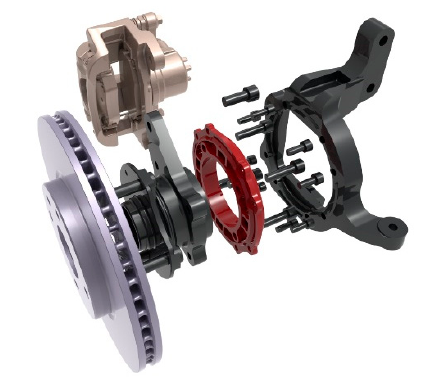
Figure 2. Installation location of the spoke-type three-component force sensor.